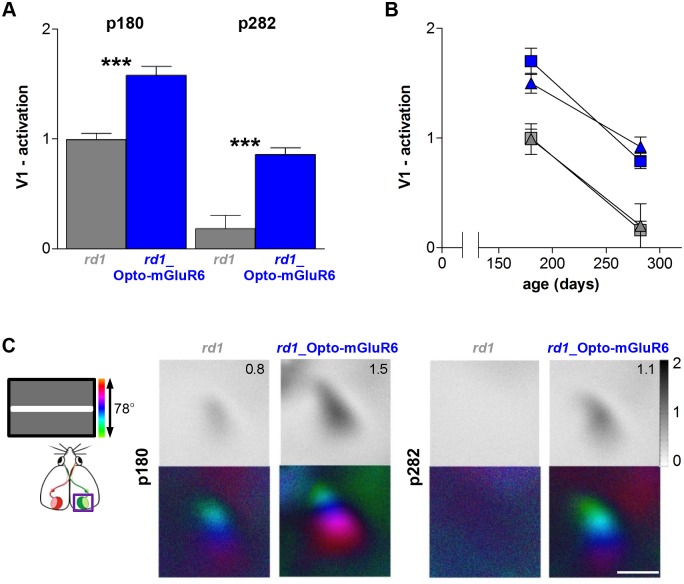

rd1_Opto-mGluR6 mice show significantly higher V1 activation compared to rd1 littermates both at p180 and p282.(A,B) Quantification of V1 activation of the right and left primary visual cortex (V1) from rd1 (grey, p180: n = 5; p282: n = 4) and rd1_Opto-mGluR6 mice (blue, p180 n = 3; p282, n = 4), plotted separately for the two ages (A) or as a function of age (B) for V1 activation of the left (squares) and right (triangles) hemispheres (mean ± SEM, ANOVA, ***p < 0.001). (C) Typical examples of binocular V1 activity maps of rd1_Opto-mGluR6 mice and rd1 littermates. The grey-scale coded response magnitude maps (upper rows) are illustrated as fractional change in reflection x 10-4. Retinotopic maps (lower rows) are color-coded according to the scheme on the left. Scale bar, 1 mm.